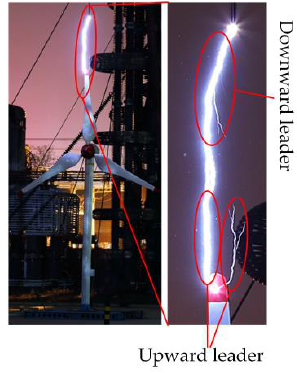
Figure 11. Breakdown phenomenon of a scaled wind turbine.